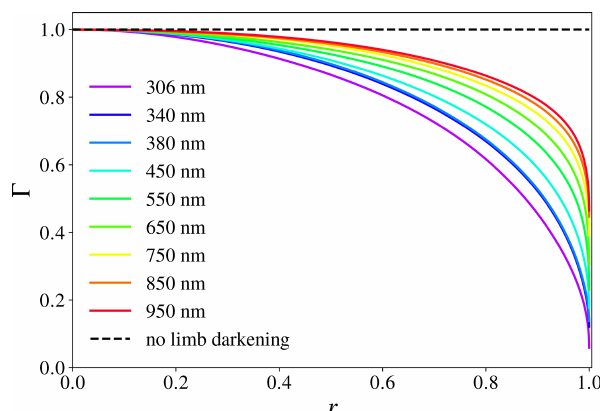
Figure 5. Limb darkening function (cid:48) for wavelengths ranging from 306 to 950nm, using the limb darkening coefficients of Pierce and Slaughter (1977) and Pierce et al. (1977), as a function of distance r from the solar disc centre (where r = 0), with r = 1 the solar limb. The dashed line is the result without solar limb darkening taken into account ( (cid:48) =